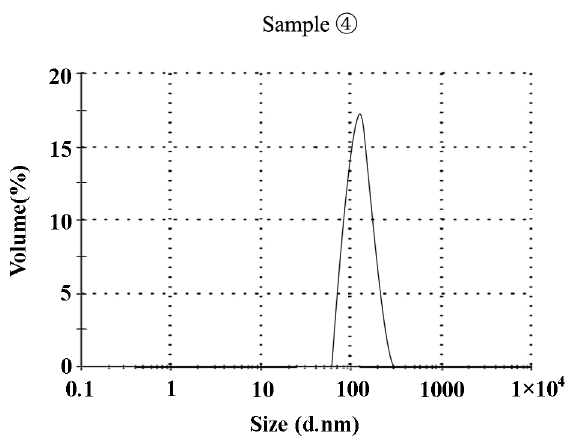
Figure 7. The particle size distribution of the system when the molar ratio of epoxy groups is E51:ED = 1:1.5. Figure 8. The particle size distribution of the system when the molar ratio of epoxy groups is E51:ED = 1:2.